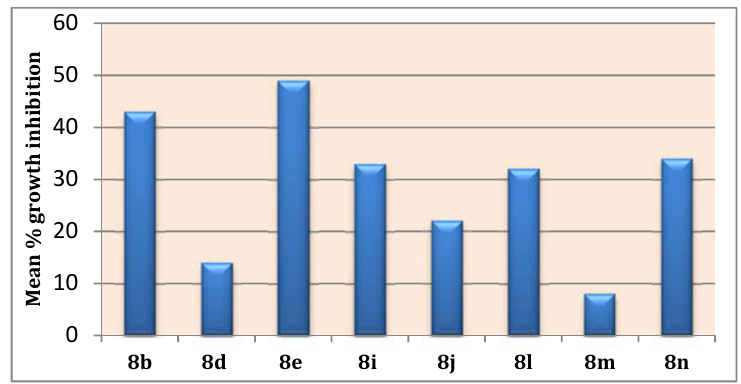
Figure 3. Mean % growth inhibitions of the tested pyridines over NCI 58 cell line panel. Interestingly, all cell lines of the leukemia subpanel were sensitive to all the tested pyridines 8b , 8d , 8e , 8i , 8j and 8l – n (GI; 10–91%), except for compound 8n towards CCRF-CEM cells. Besides, non-small cell lung cancer (A549/ATCC, HOP-92 and NCI-H522), colon cancer (HCT-116 and HT29), melanoma (M14 and SK-MEL-5), renal cancer (A498 and UO-31), prostate cancer (PC-3) and breast cancer (T-47D and MCF7) were susceptible cell lines to all the screened compounds. The most sensitive cell lines towards the target pyridines were displayed in Figure 4A,B. Molecules 2018 , 23 , x